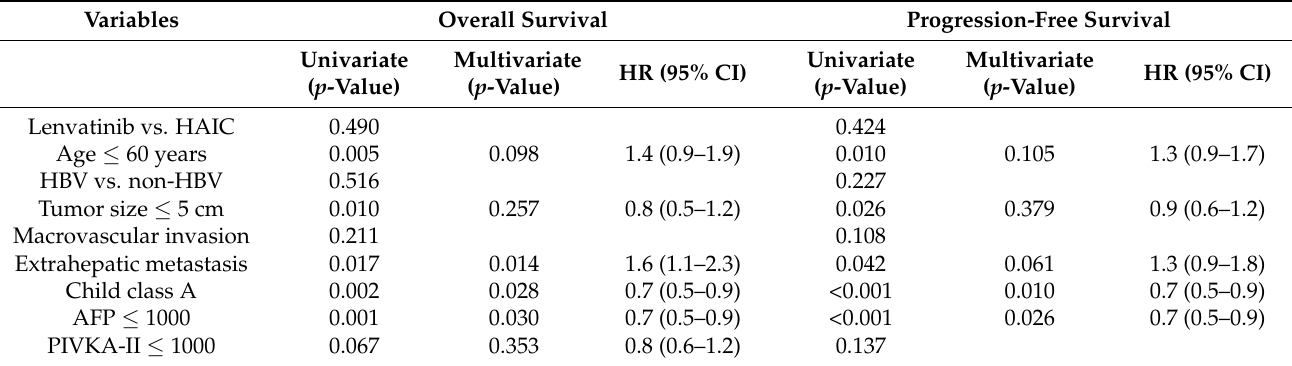
Table 3. Univariate and multivariate analyses of the factors influencing OS and PFS in the entire